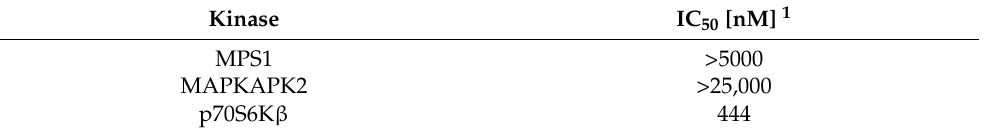
Table 1. IC 50 values of compound 1 on selected kinases featuring a cysteine in the middle hinge region. Kinase